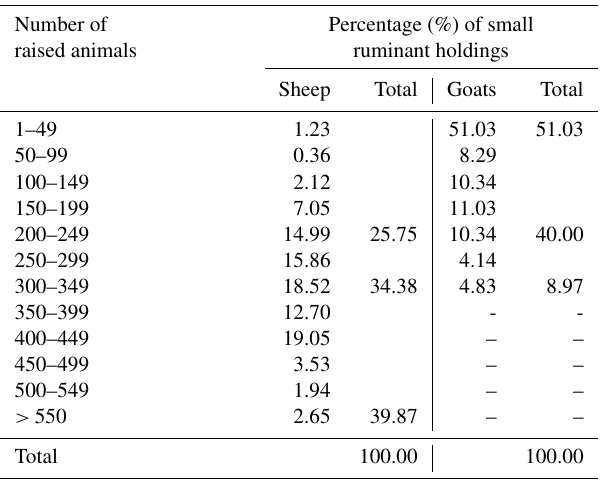
Table 2. Percentage (%) of holdings according to the number of raised sheep and